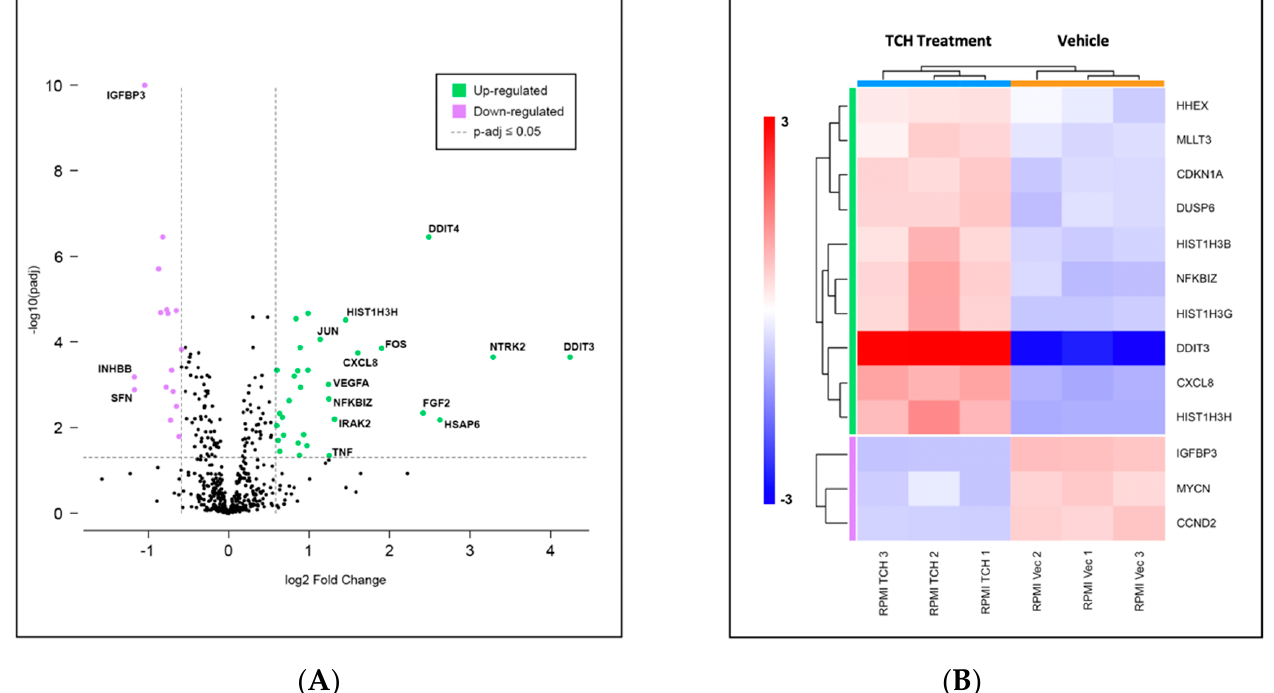
Figure 4. ( A ) Volcano scatter plots of genes in cancer pathways analyzed by the PanCancer multi- plexed transcript detection assay. Dotted vertical lines indicate a 1.5-fold change in normalized gene expression, with overexpressed genes in green and under-expressed genes in purple. Labels indicate genes showing over 2-fold change; ( B ) Changes in gene expression observed over three independent experiments indicating transcriptional misregulation are presented in the heatmap. Consistent with the upregulation of the DNA damage response, we demonstrated induction of apoptosis in all three MM cell lines (Figure S1).